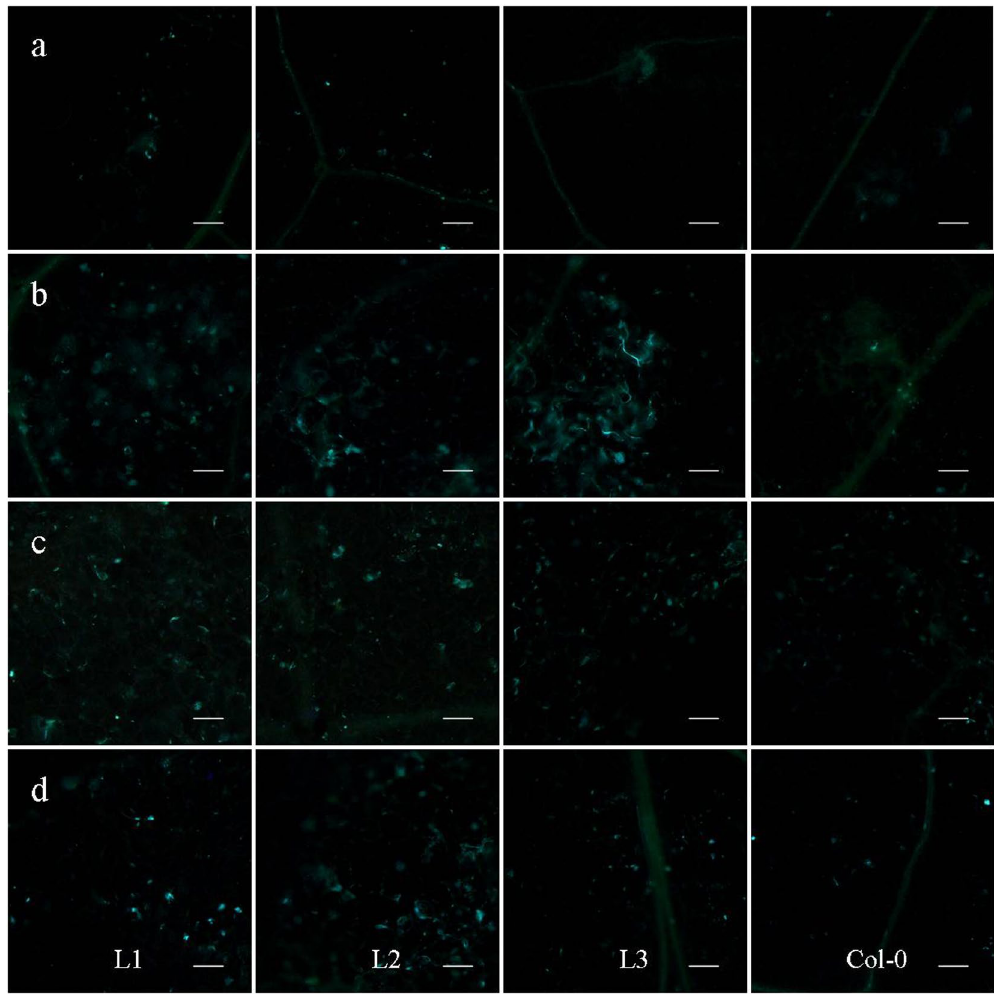
with ( a ) Mock sample (MgSO 4 ), ( b ) DC3000, ( c ) flg22 and ( d ) LPS, and photographed with the microscope. Three diseased leaves of the transgenic lines and Col-0 were required in three independent experiments. The scale bar in the figure indicates 100 μ